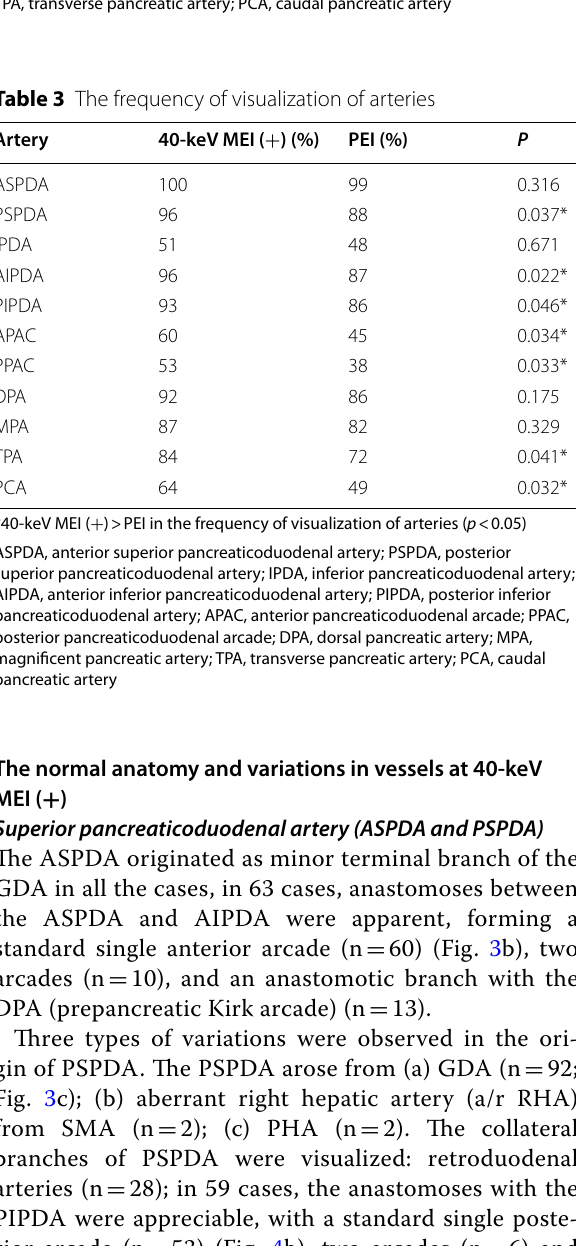
Data shown are mean standard deviation ± *Scores for 40-keV MEI ( ) > scores for PEI ( p < 0.05) + ASPDA, anterior superior pancreaticoduodenal artery; PSPDA, posterior superior pancreaticoduodenal artery; IPDA, inferior pancreaticoduodenal artery; AIPDA, anterior inferior pancreaticoduodenal artery; PIPDA, posterior inferior pancreaticoduodenal artery; DPA, dorsal pancreatic artery; MPA, magnificent pancreatic artery; TPA, transverse pancreatic artery; PCA, caudal pancreatic artery